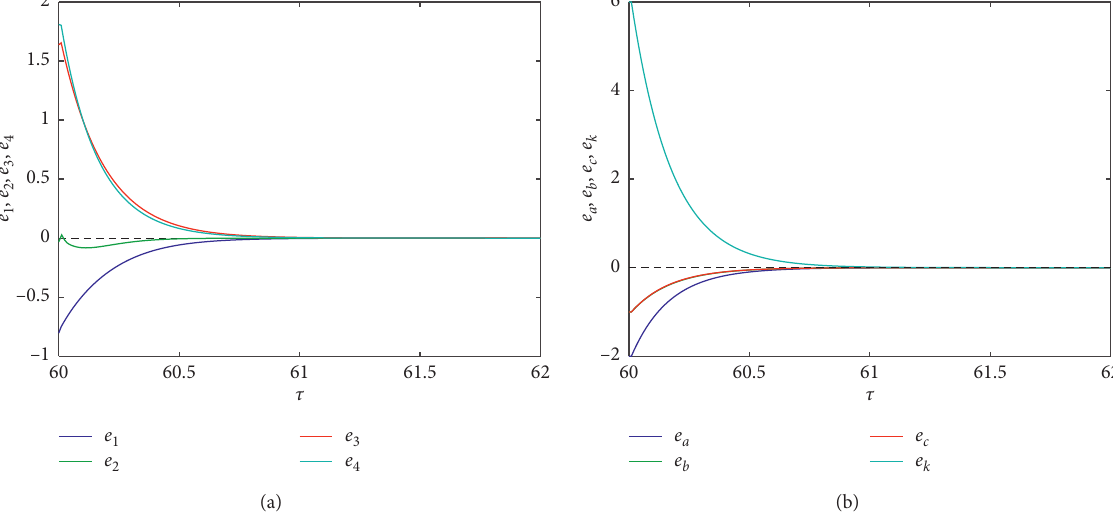
, e , e , and e and the parameter estimation errors e a , e b , e c , and e k directly after 1 2 3 4